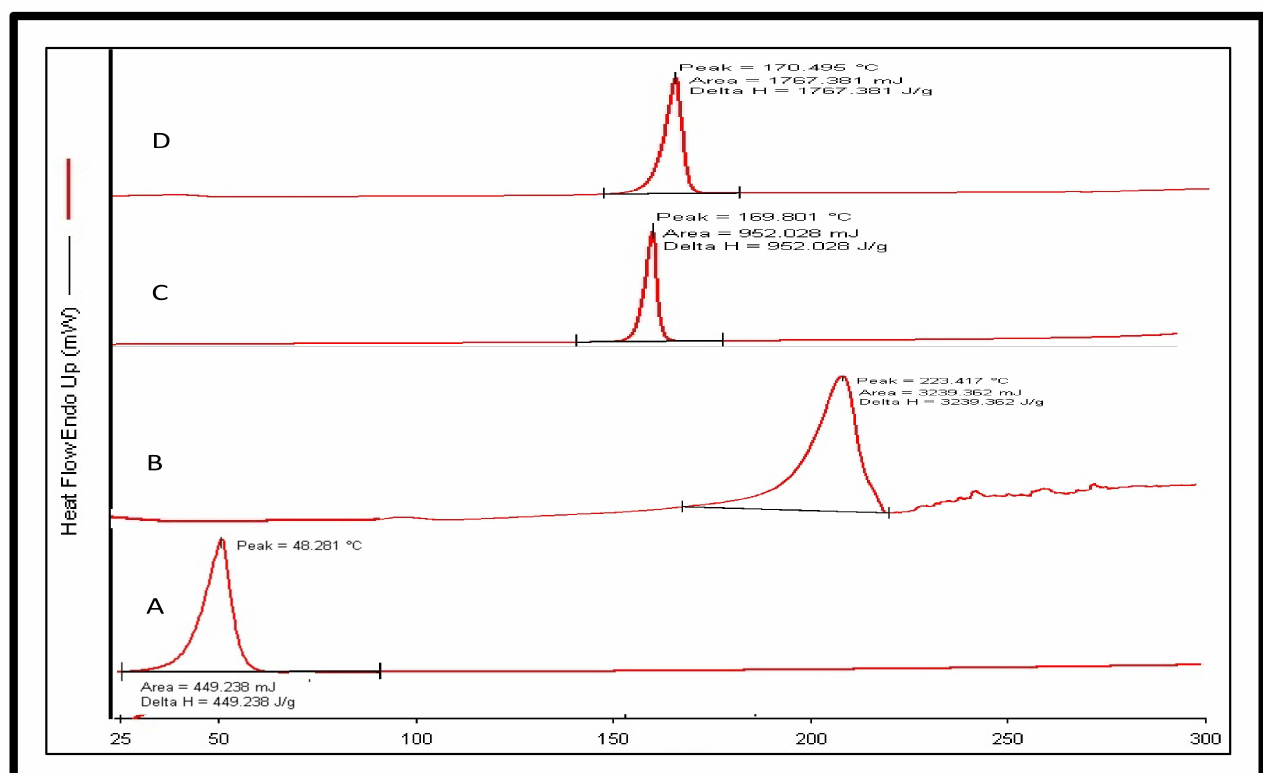
Figure 6. Overlay of differential scanning calorimetry (DSC) ( A ) (thymoquinone), ( B ) (fulvic acid), ( C ) (mannitol), and ( D )